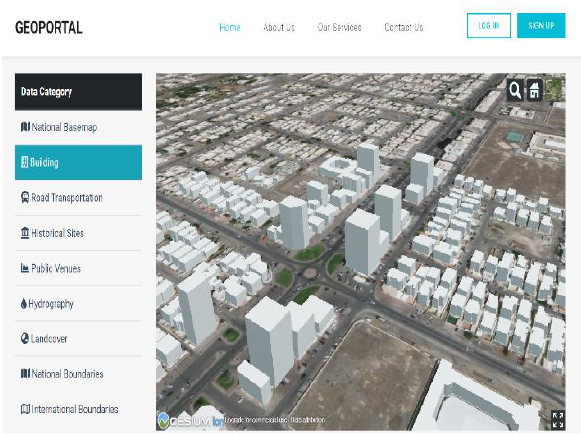
Figure 5 . The developed 3D SDI data service for spatial data query, explore, share and download among various agencies in Oman.